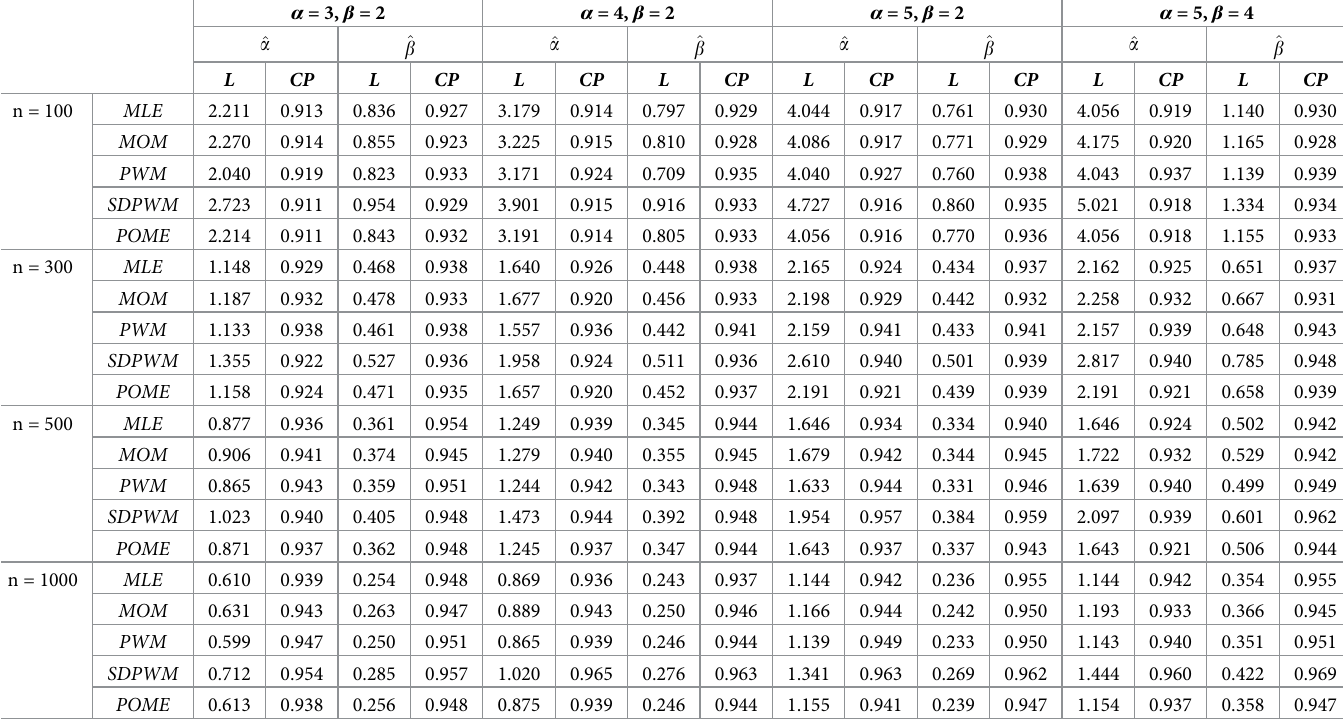
Table 10. The average length (L) and coverage probability (CP) of the bootstrap confidence intervals for α and β when α < β and for different choices of n